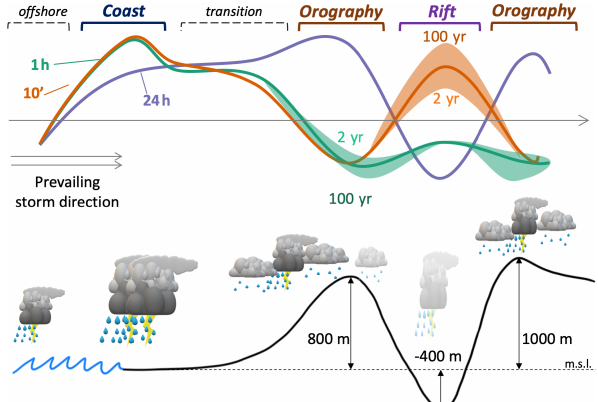
Figure 8. Schematic representation of the coastal and orographic effect on extreme precipitation. The qualitative impact of local ter- rain features (sea–land interface, orographic barriers, and rift valley depression – displayed at the bottom with a black line) on extreme precipitation return levels of 10min (orange line) and 1 (green) and 24h (purple) is summarized. The different response of mild (2 year, i.e., 50% yearly exceedance probability) and extremely se- vere (100 year, i.e., 1% yearly exceedance probability) return levels of short duration (10min, 1h) to orographic features, which comes as a consequence of the response of the shape parameter of the ordi- nary events distribution, is displayed using color shades. At the bot- tom portion of the figure, regions where short-duration convective processes dominate extreme precipitation are indicated with thun- derstorms, while regions in which stratiform-like processes and the aggregation of many rain cells dominate extreme precipitation are indicated with thinner precipitating clouds surrounding the thun- derstorms. Semi-transparent clouds in the rift indicate that the local occurrence frequency of precipitation events is